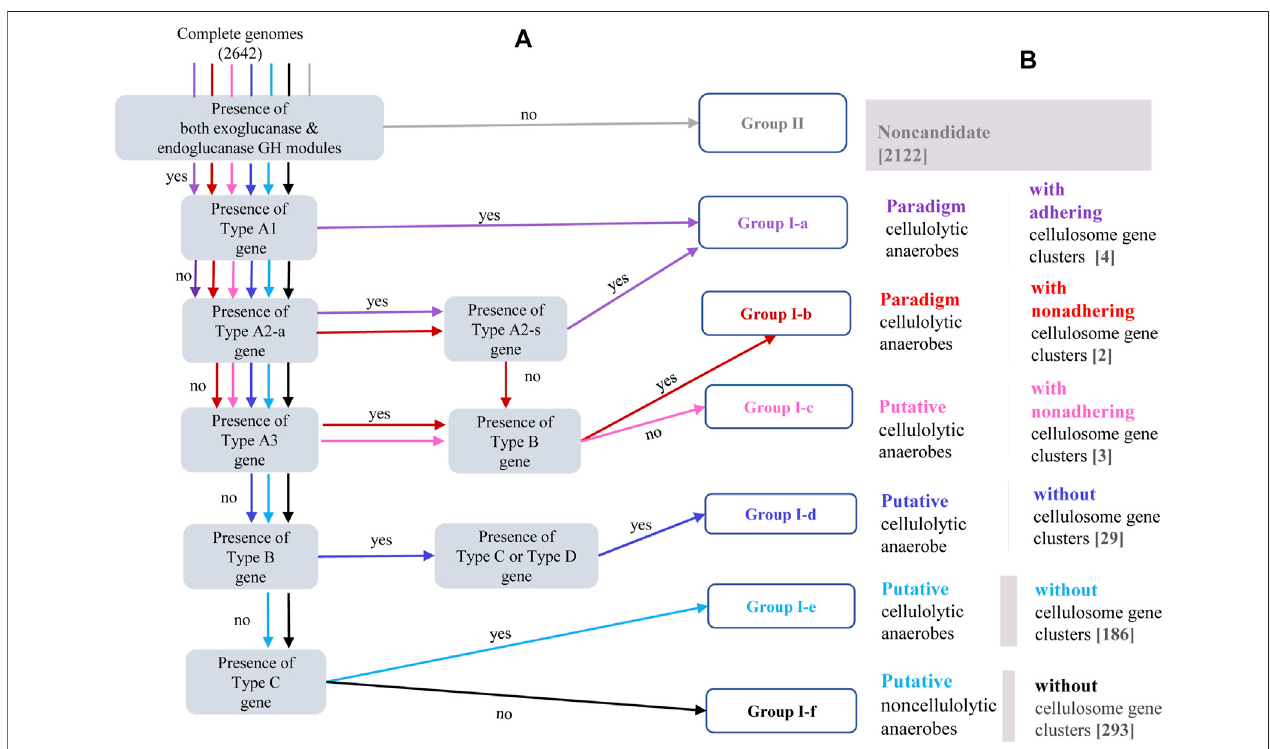
FIGURE 2 | (A) Schematic description of the categorization procedure embedded in the bioinformatic pipeline for genome-centric identi fi cation and categorization of putative cellulolytic anaerobes. Different colors are allocated to different paths through which genomes of Group I-a [purple], Group I-b [red], Group I-c [pink], Group I-d [blue], Group I-e [sky-blue], Group I-f [black], and Group II [grey] were identi fi ed and categorized; in each shaded bracket is one criteria to be checked; genomes meeting one speci fi c criteria will be passed to a downstream criteria led by the “ yes ” arrow, otherwise, be passed to a downstream criteria led by the “ no ” arrow; and each genome will be subjectedtoseriesofcriteriacheckbeforethisgenomewouldbeassignedtoaspeci fi cgroup.Thegenetypes (A1,A2-a,A2-b,A3,B,CandD) speci fi edineachshadedbracket have been de fi ned in Table 1 and schematically visualized in Figure 2 . (B) Corresponding phenotype description of each genotype category, numbers in the brackets indicate number of complete genomes assigned into each genotype